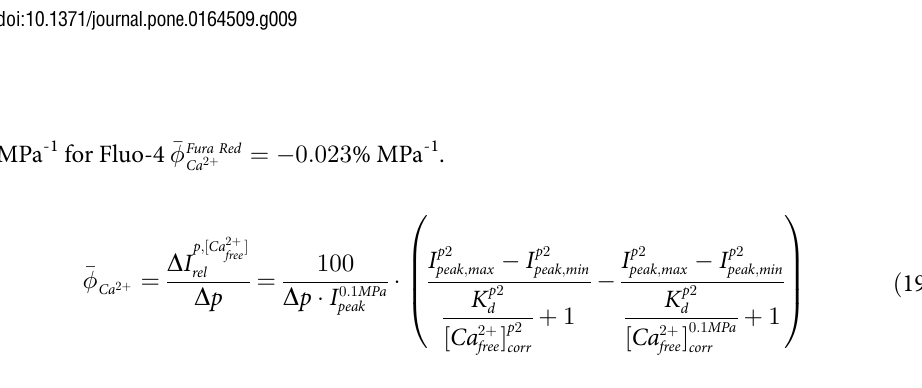
Fig 9. Flowchart of the pressure dependent system variables and their influence on the measured dye fluorescence intensity of Fluo-4 and Fura Red. A positive influenceis indicatedby a grey- a negative influenceby a black arrow. The mean overall fluorescence change (cid:22) (cid:30) that is caused by each variable is shown as a label on each arrow. The relative magnitudeof the influenceof each variable is illustratedin the arrow